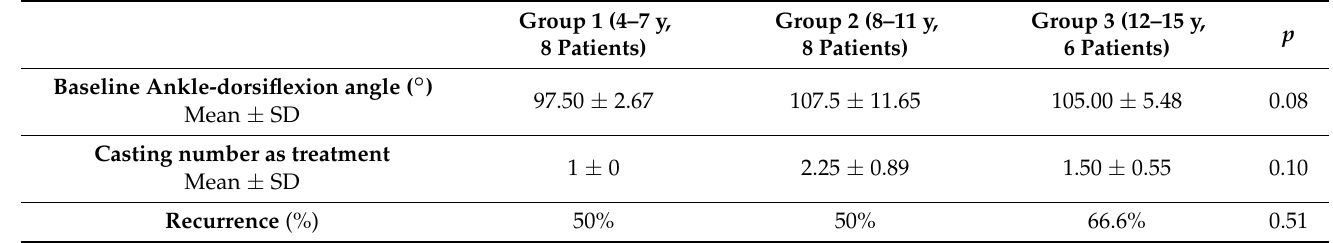
Table 3. Correlation between group and recurrence (tau-b Kendall), comparison between sex and baseline ankle-dorsiflexion angle ( ◦ ), cast numbers as treatment (Kruskal–Wallis test).